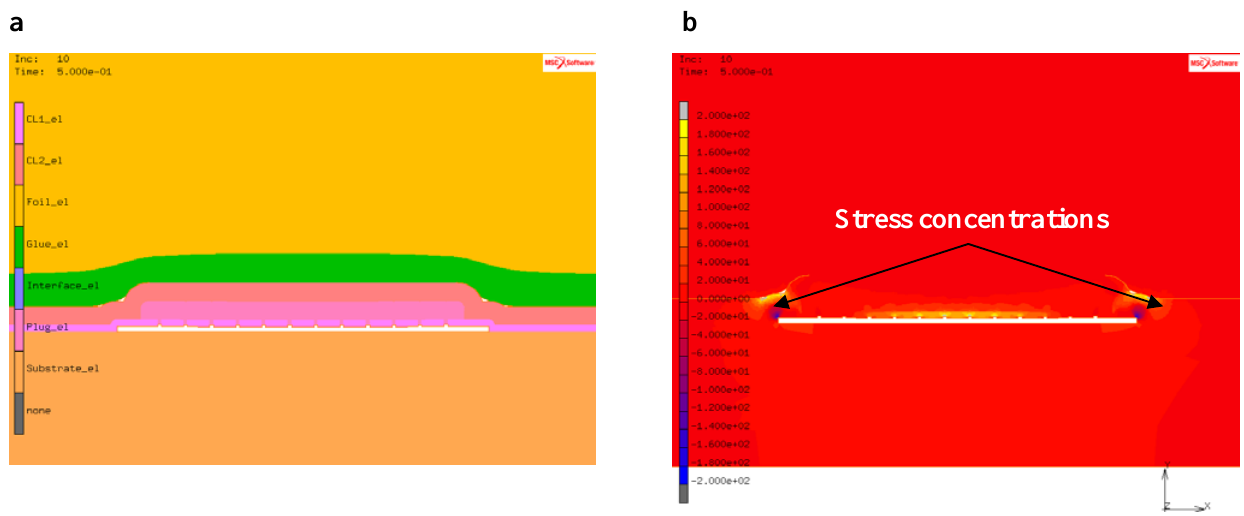
Figure 6. (a) Tape application deformations; (b) Stress distribution during tape